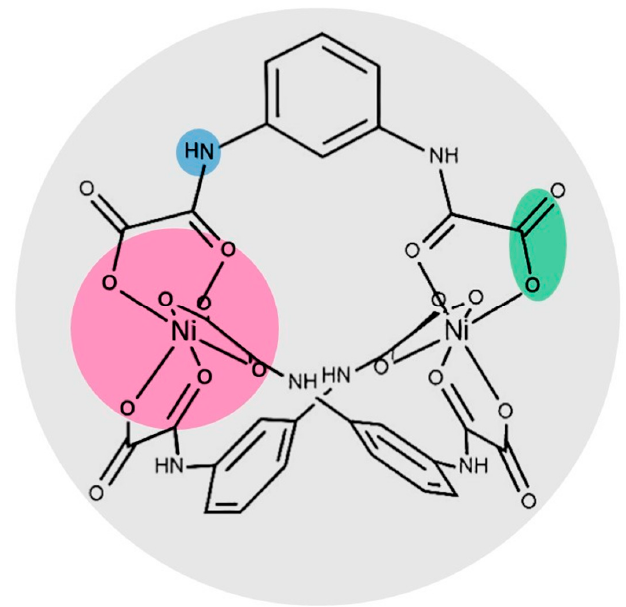
Figure 1. Structure of the [Ni 2 (H 2 mpba) 3 ] 2– helicate highlighting the regions of the primary coordination environment of Ni II and the available sites to establish supramolecular interactions: hydrogen bond donor (blue), primary coordination environment of Ni II (pink), free moieties for coordination and supramolecular interactions (green), and anionic species assessing different counter cations (gray).